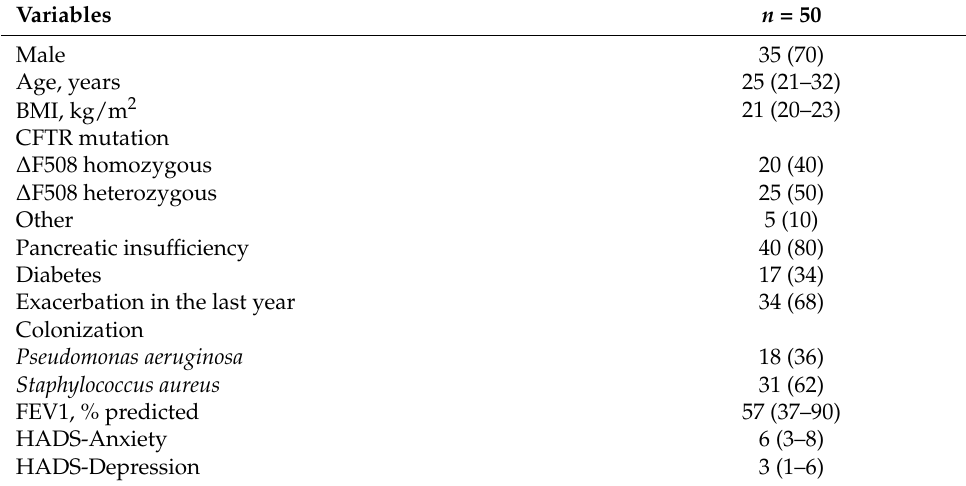
Table 1. Demographic, clinical, functional, and microbiological